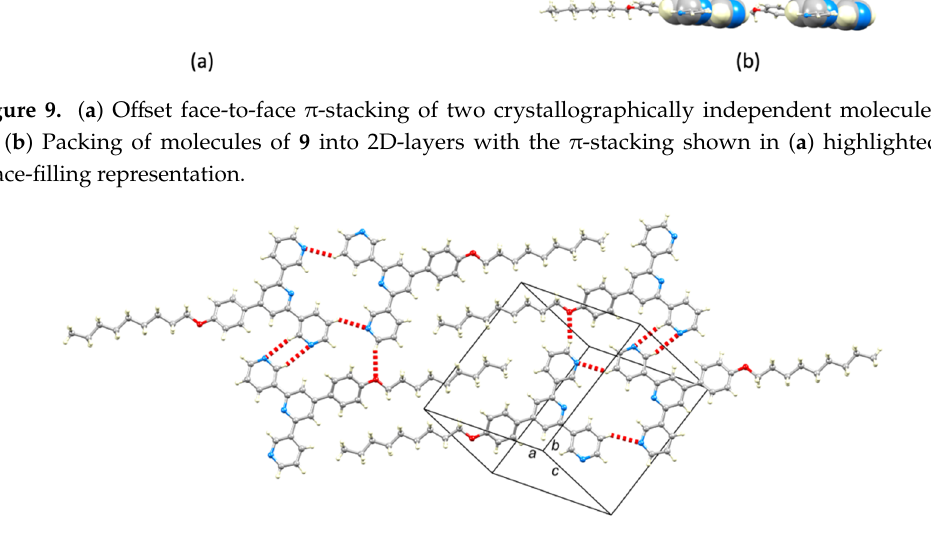
Figure 10. Packing of molecules of 9 within one 2D-sheet involves a combination of C–H...N and C–H...O weak hydrogen bonds (red hashed lines) and van der Waals interactions between n -nonyloxy chains. Figure S16 (in the Supplementary Materials) shows this packing in a space-filling representation.